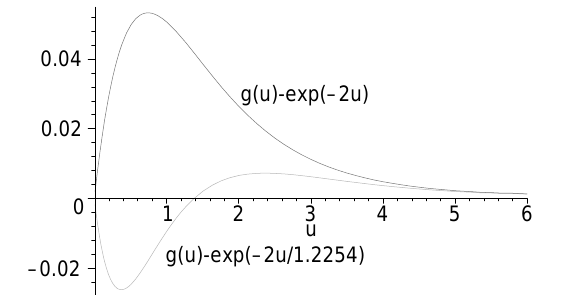
FIG. 5. Difference between g (cid:1) u (cid:2) and e 2 2 u , e 2 2 u (cid:3) 1.2254 .